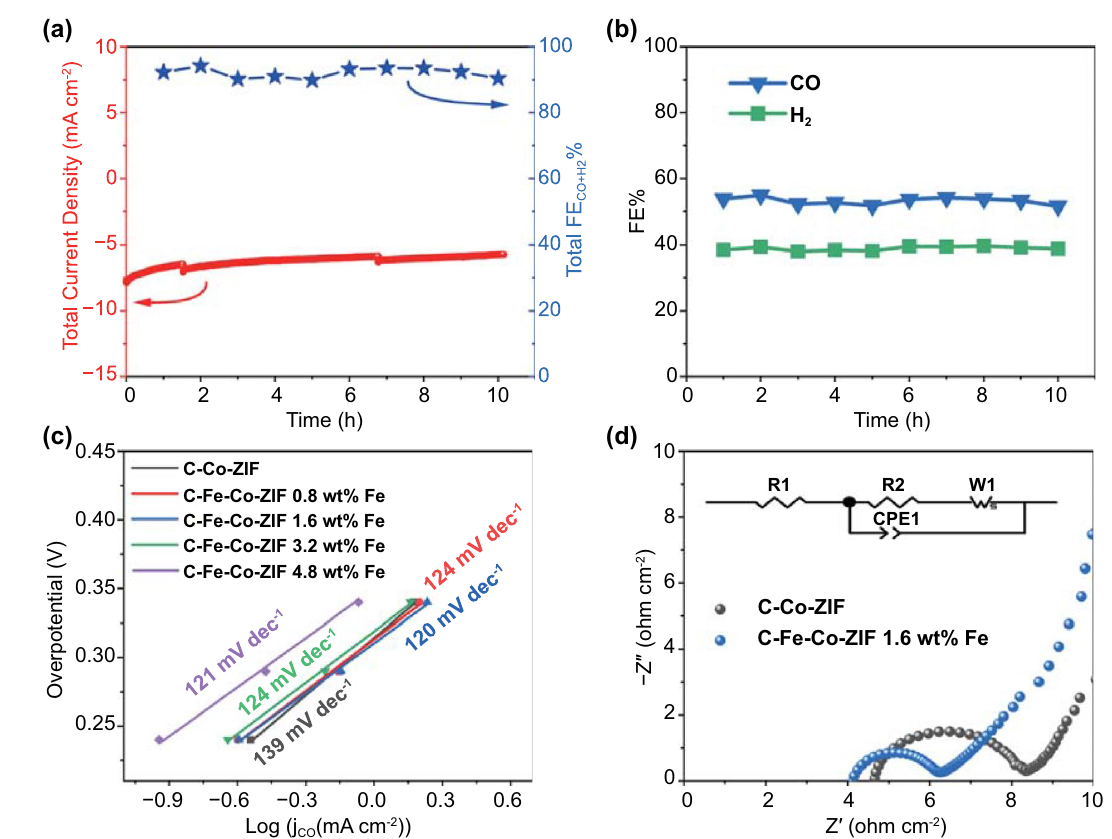
Fig. 7 Chronoamperometry test of a Total current density and total FE CO+H2 , b FE CO and FE H2 of C–Fe–Co–ZIF-1.6 wt%-Fe at -0.55 V versus RHE under CO 2 atmosphere for the stability evaluation. c Tafel slopes of C–Fe–Co–ZIF catalyst electrodes with different Fe adding amounts. d EIS results of C–Co-ZIF and C–Fe–Co–ZIF-1.6